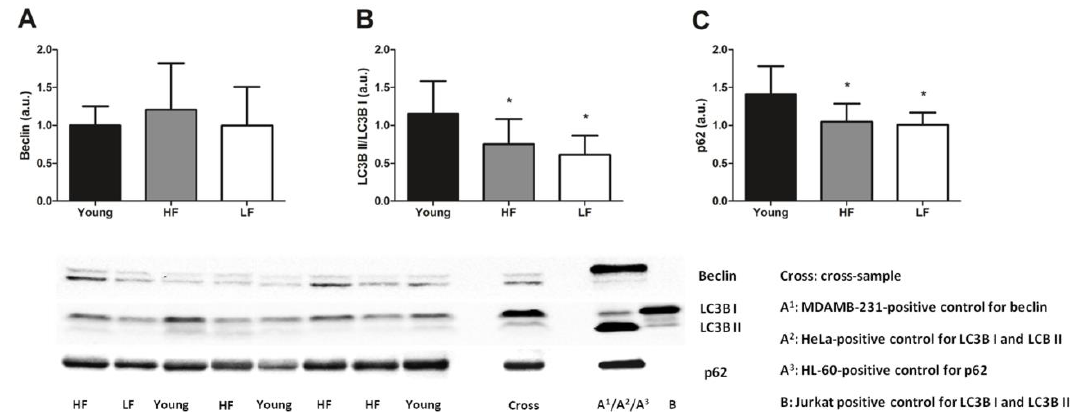
Figure 4. Selected markers of general autophagy in the vastus lateralis muscle of young and old participants. Comparison by one-way ANOVA of ( A ) protein levels of beclin, ( B ) ratio between lipidated (II) and non-lipidated (I) microtubule-associated protein 1A / 1B-light chain 3 (LC3B), and ( C ) protein levels of p62 among young participants ( n = 11) and high- (HF, n = 16) and low-functioning (LF, n = 7) older adults. Bars represent mean values ( ± standard deviation) for the three experimental groups. Values are expressed in arbitrary units (a.u.) and representative blots are shown for each protein. * p < 0.05 vs. young group .